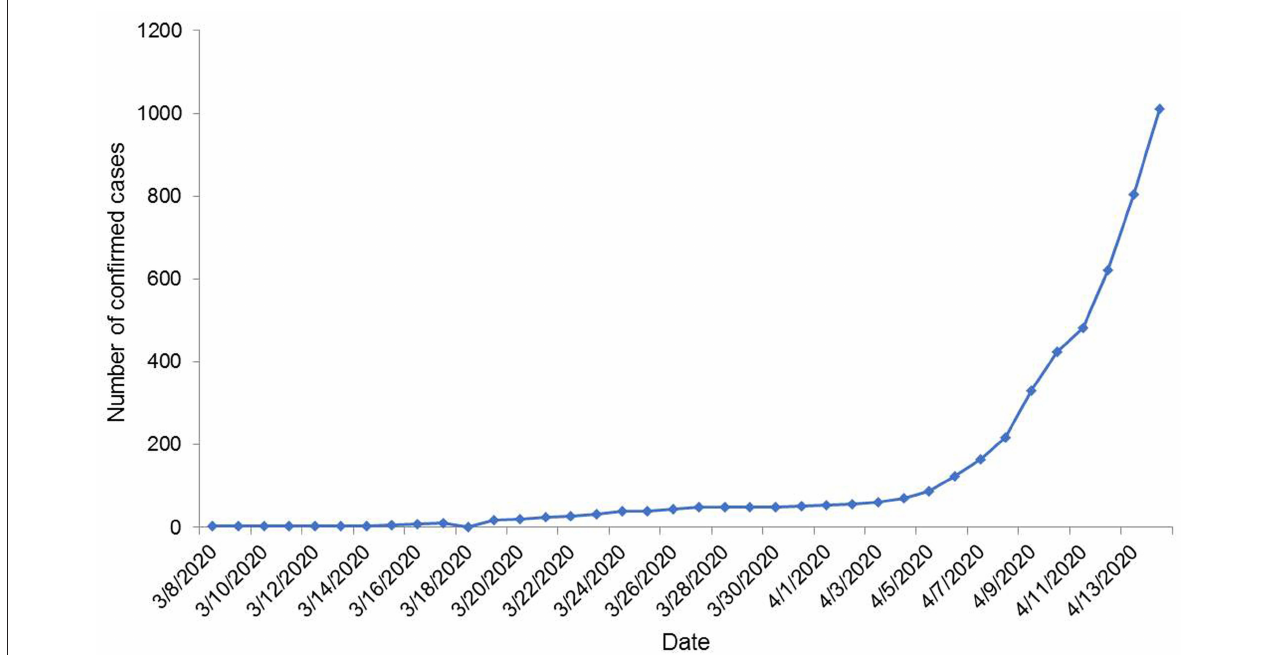
FIGURE 1 | Temporal distribution of the number of COVID-19 confirmed cases in Bangladesh until 14 April 2020.